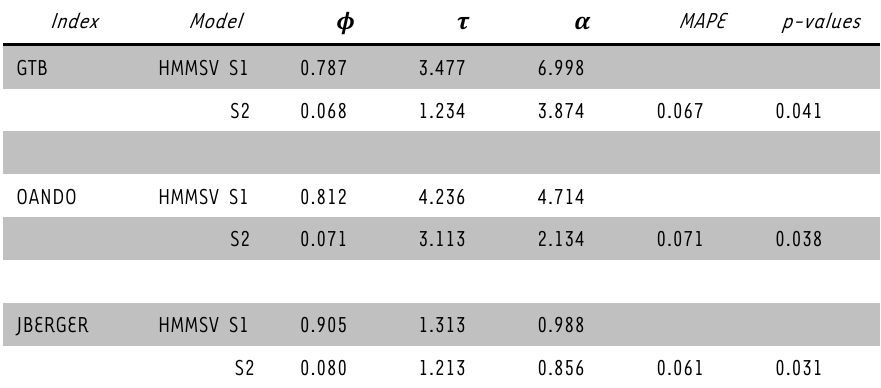
TABLE 5: Statistical performance results from HMM-SV